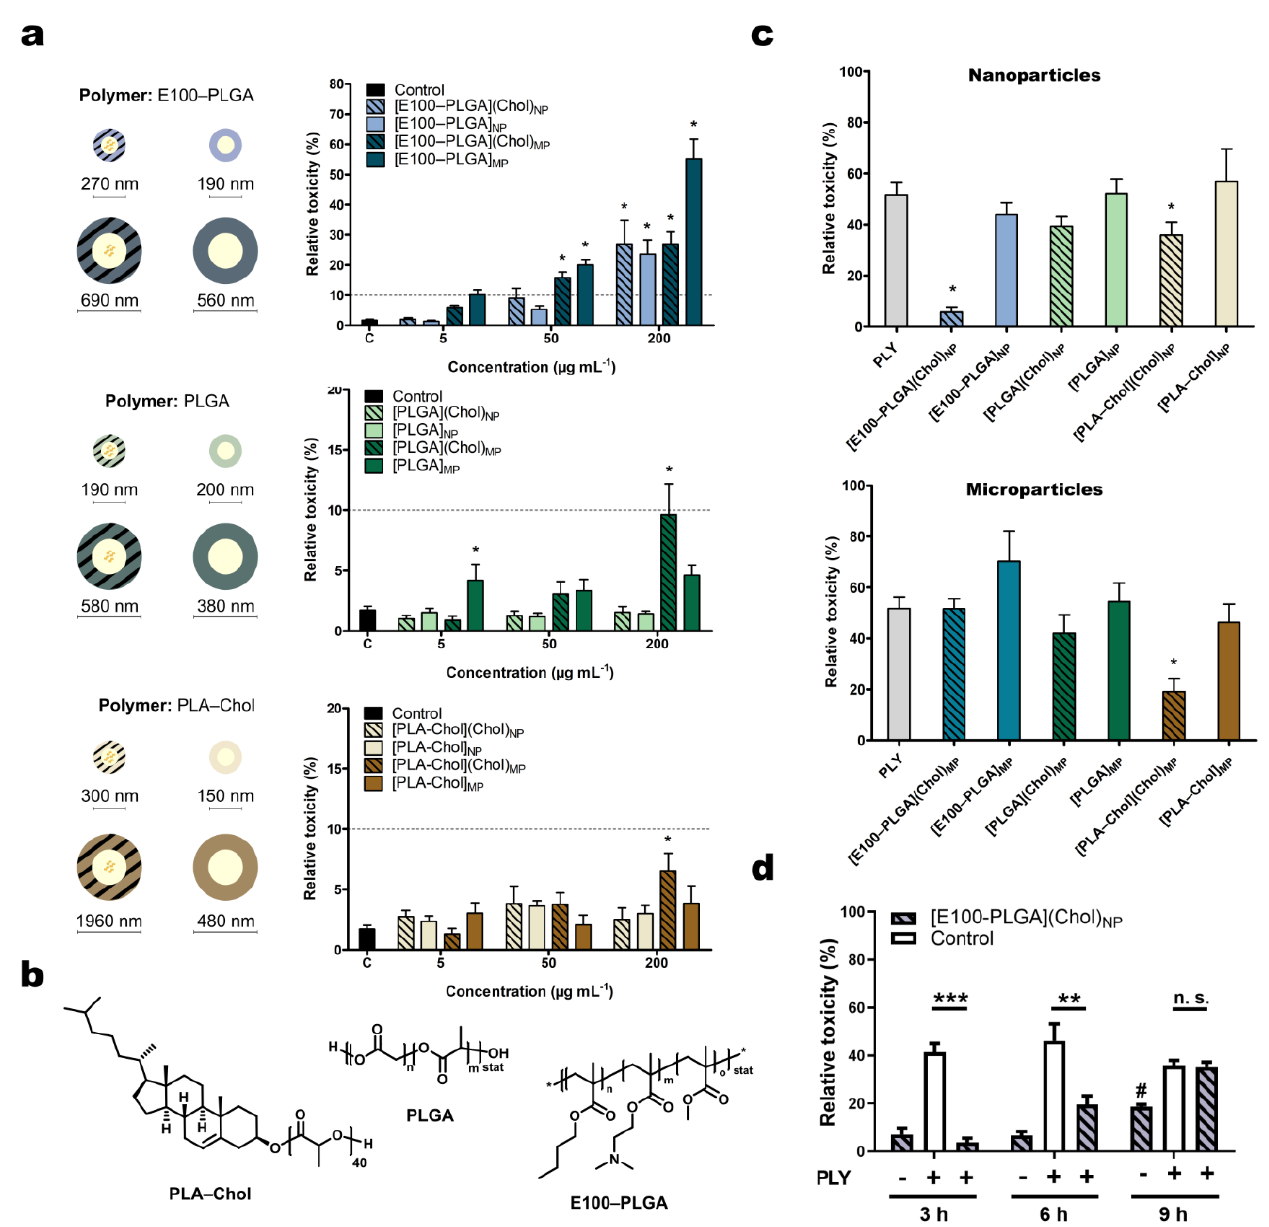
Figure 1. Evaluation of cell toxicity after polymer particle stimulation or pneumolysin stress. ( a ) HepG2 cells were treated with polymeric particles prepared by nano- or microprecipitation (NP or MP, respectively) of indicated concentrations in DMEM:F12 for 3 h. Stripes indicate the cholesterol cargo of the polymer particle. Mean diameter size (rounded) of tested sample and polymer composition ( b ) after lyophilization is shown. The polymer surface was coated with poly(2-oxazoline) (POx). ( c ) Cells were challenged with PLY (250 ng mL − 1 ) for 3 h in the presence of nano- or microprecipitated particles (50 µ g mL − 1 ) before toxicity was examined by the release of cytoplasmic LDH. ( d ) Amelioration of PLY toxicity by [E100–PLGA](Chol) NP was found to be time-dependent. Mean ± SEM toxicity is shown relative to completely lysed cells (= 100%). * p < 0.05, ** p < 0.01, *** p > 0.001, one-way ANOVA, corrected for multiple comparisons against untreated control ( a ) or PLY ( c , d ) (Dunnett’s test).